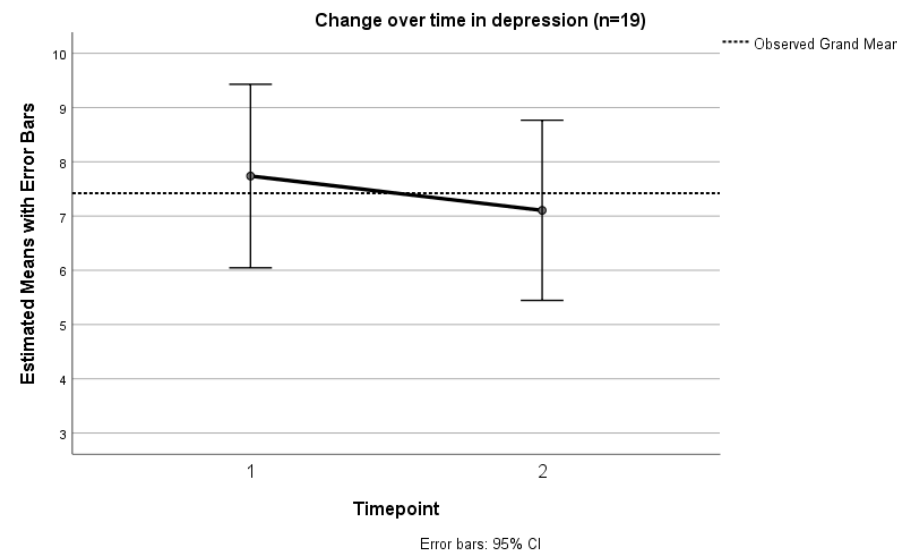
Figure 4. Change over time between T1 and T2 ( n = 19) in depression.